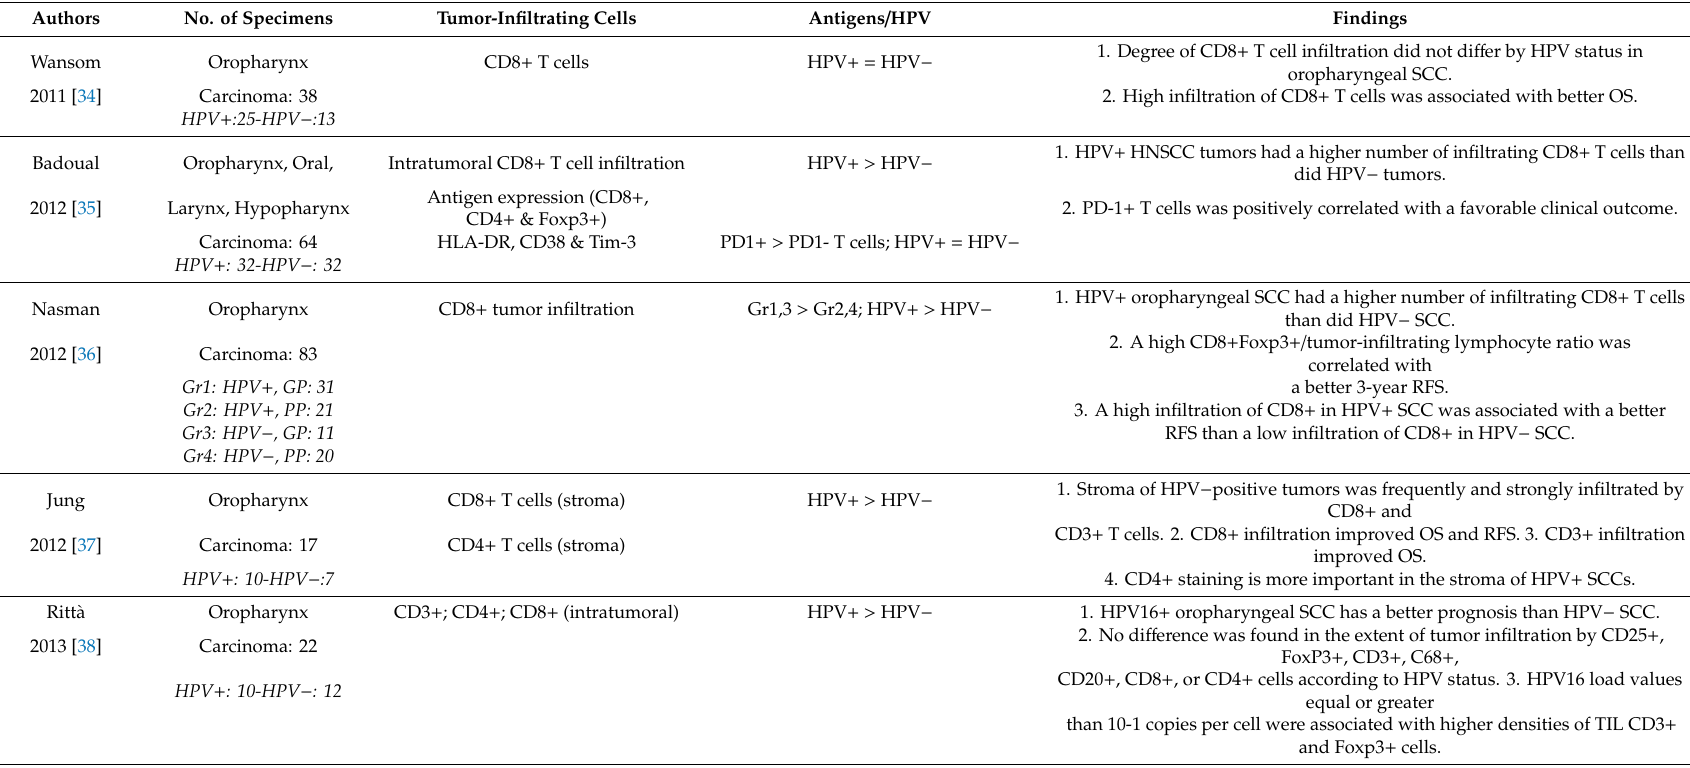
Table 3. CD8 + and CD4 + infiltration in HPV + and HPV − Head & Neck Squamous Cell